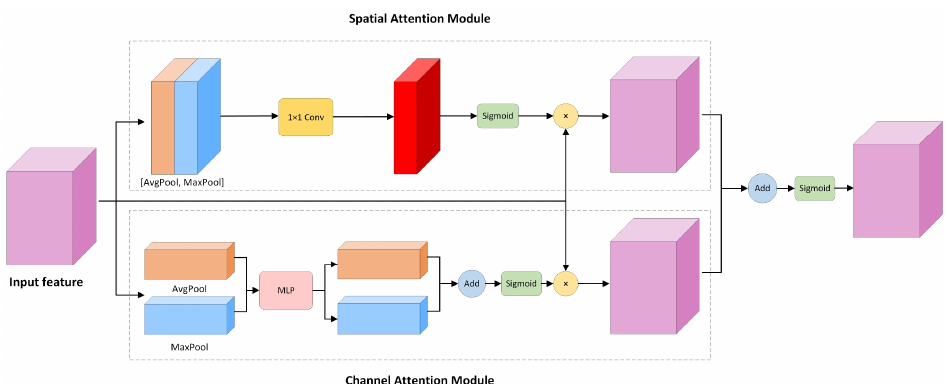
Figure 3. A Spatial-channel attention mechanism module that can be embedded in a convolutional neural network .